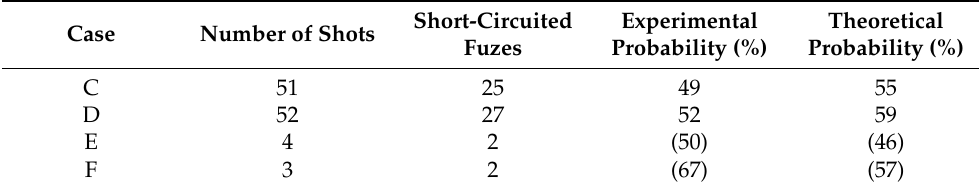
Table 4. Experimental results for the four considered metallic net armour configurations and a comparison with their theoretical